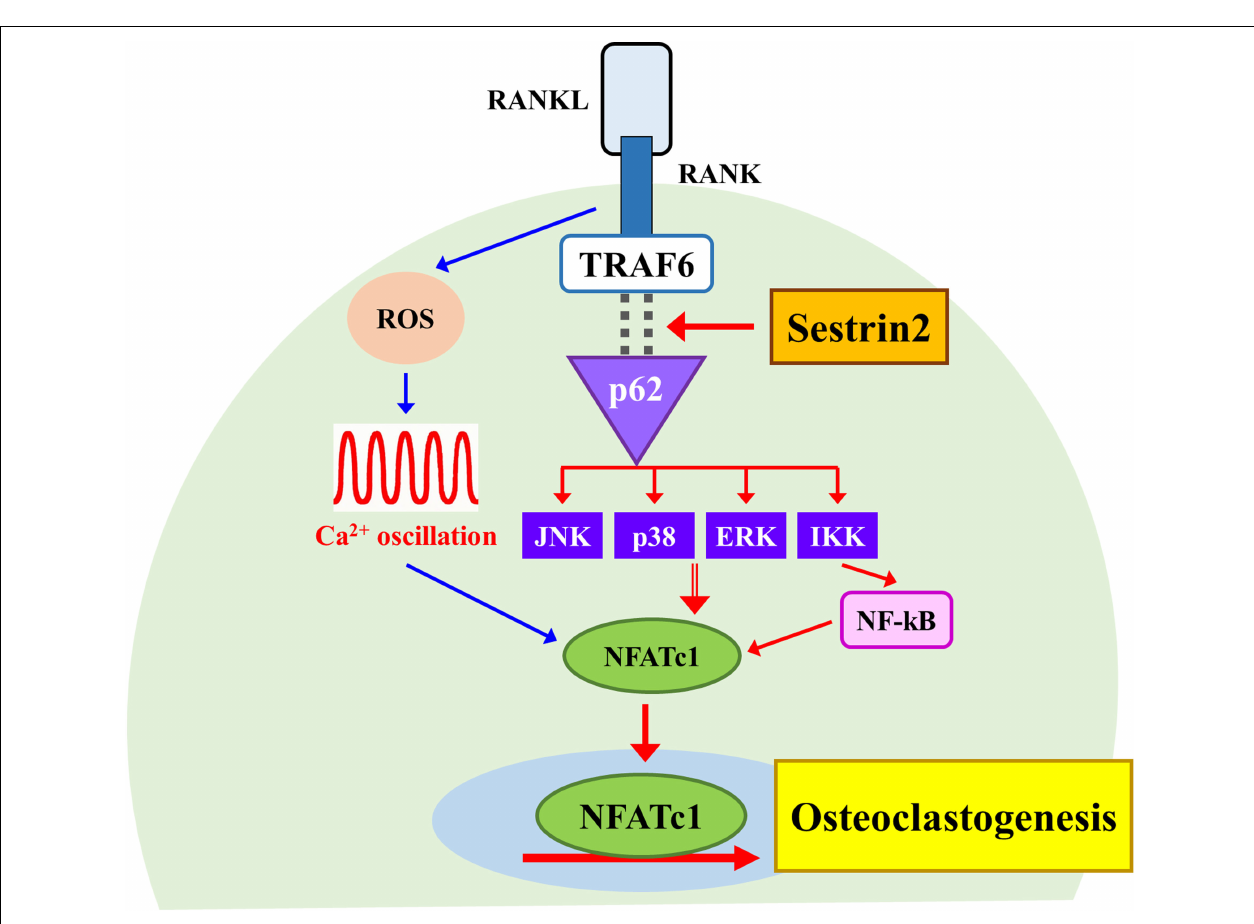
FIGURE 5 | A schematic diagram for the regulatory mechanism of osteoclast differentiation by Sestrin2. The model shows the activation of NFATc1 requires Sestrin2-mediated activation for the TRAF6/p62 interaction (red arrows). The sequence of events activated by RANKL also induces the ROS generation and Ca 2 + oscillations that are required for the activation of NFATc1 regardless of Sesstrin2 (blue